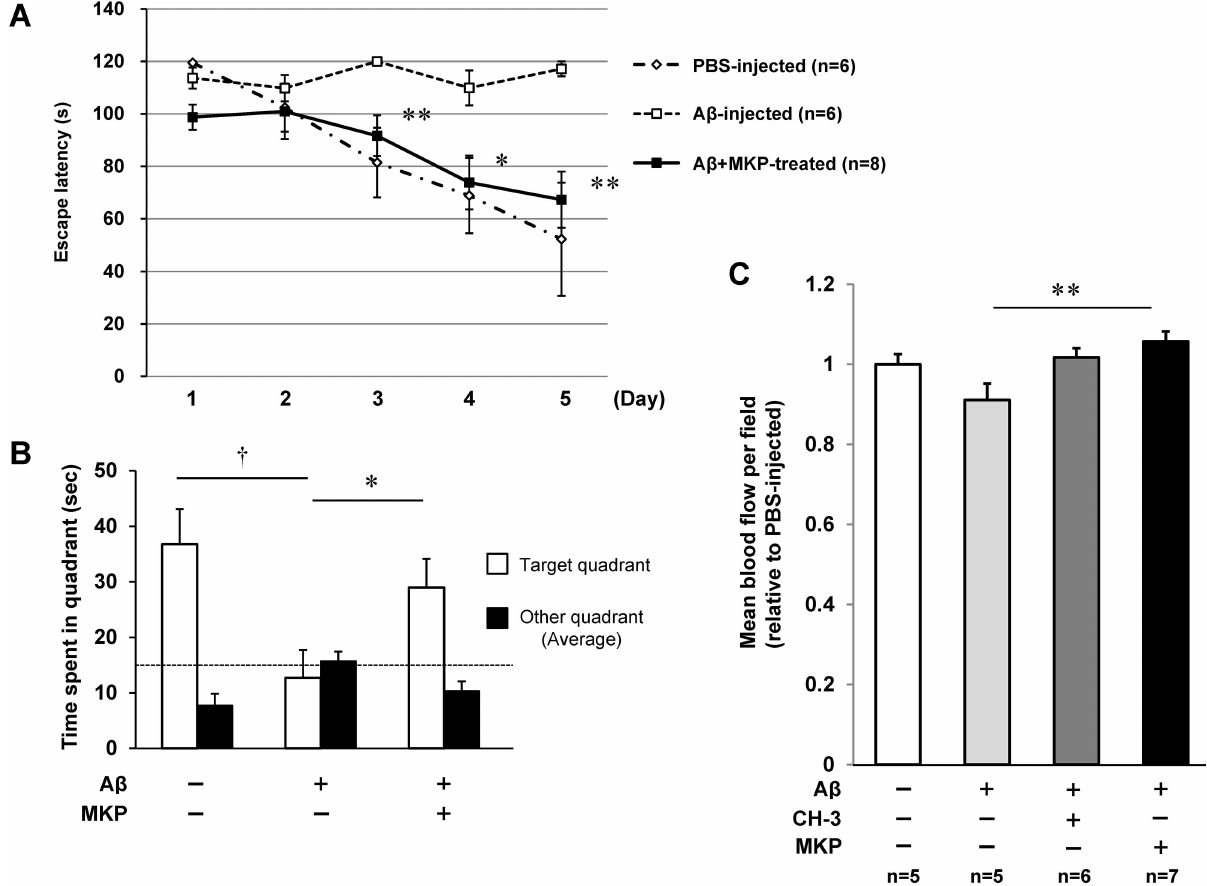
Fig 4. Improvement of cognitive decline by MKP treatment in AD model mice. ( A ) Swim latency in Morris water maze test. ( B ) Time spent in target quadrantincludingthe former platform positionin Morris water maze test. ( C ) Cerebral blood flow measured by laser speckle flowmetry after Morris water maze test. MKP was orally administered to mice every day at 0.5 mg/kg/day starting 2 days before A β 1–42 injection. n = 5–8 mice in each group. † P < 0.05vs. control, * P < 0.05or ** P < 0.01vs. A β 1–42(+).